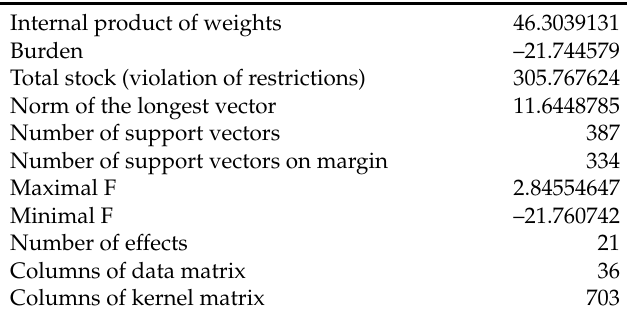
Table 5. Results of SVM